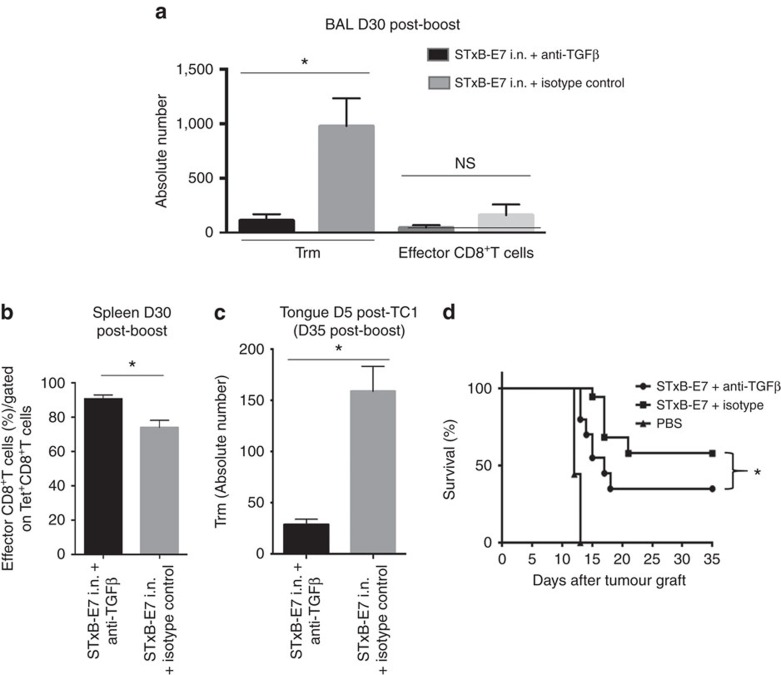
Modulation of Trm by TGFβ neutralization decreases cancer vaccine efficacy.Mice were i.n. immunized (prime-boost) by STxB-E7 and treated in parallel by an anti-TGFβ or its isotype control. Treatment was stopped 1 week after the boost. Trm and effector CD8+T cells were measured 30 days after the boost in the BAL (a) and effector CD8+T cells were counted in the spleen 30 days after the boost (b). Mice were grafted with TC1 cells in the tongue 30 days after the boost, and 5 days later the number of Trm was measured in the tongue submucosae by flow cytometry to enumerate the absolute number of Trm in the presence or absence of anti-TGFβ (c). (d) Survival analysis of mice immunized by STxB-E7 combined or not with the anti-TGFβ treatment and grafted 30 days after the boost with TC1 cells. Experiments were performed with at least six mice per immunization group and repeated three times. Statistical analysis for (a–c) used non-parametric Mann–Whitney test and for (d) a Log-rank test. *P<0.05. Error bars indicates s.e.m. NS, not significant.